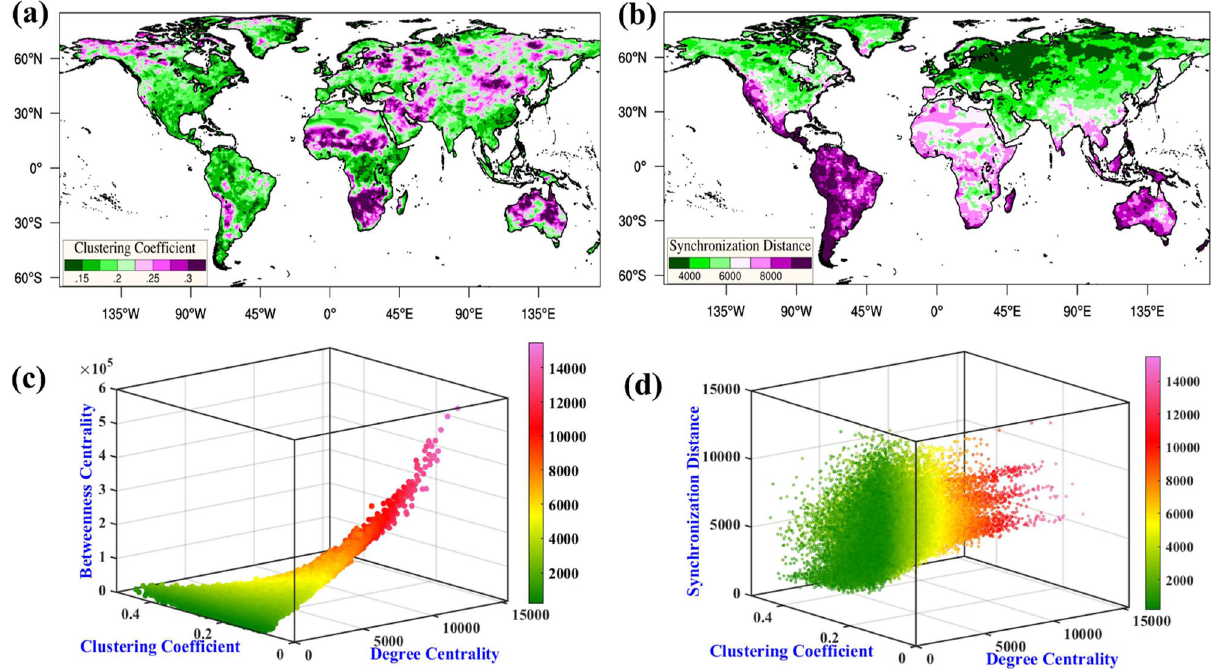
Fig. 2 | Regionaltopology & spatial scale ofsynchronization ofglobaldrought events. a Clustering coef fi cient (CC), b Mean synchronization distance (MSD) of the global drought network, JOint distribution of c degree centrality (DC), betweenness centrality (BC), clustering coef fi cient (CC), and d degree centrality